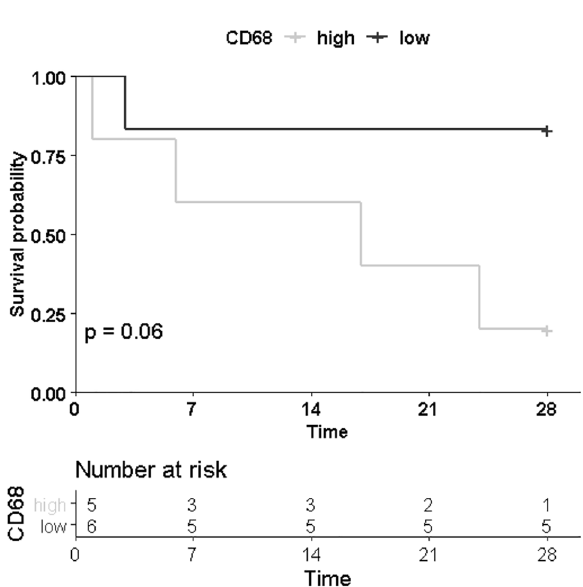
Figure 4. Kaplan–Meier estimated curve of 28-day survival of patients suffering from peritoneal sepsis based on CD68 immunostaining in human skeletal muscle. 28-day survival was lower in patients with high number of infiltrating CD68 positive cells but not statistically significant in log-rank test (p = 0.06). CD68, cluster of differentiation